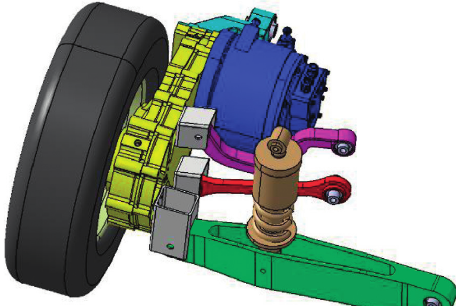
Figure 12: Integrated E-type multilink suspension wheel-side drive